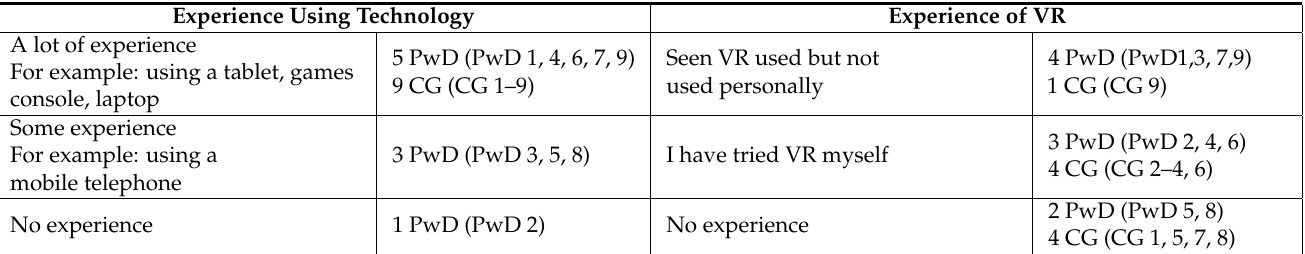
Table 4. People living with dementia (PwD) and caregiver (CG) experience using technology and VR. Experience Using Technology Experience of